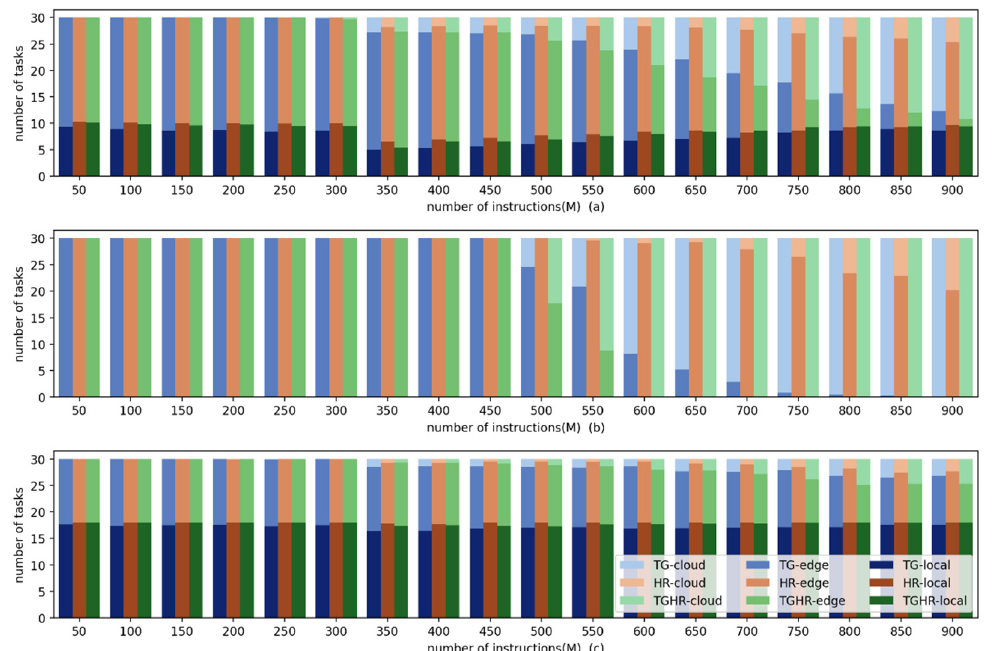
Figure 15. Allocation ratio of resource in different number of task instructions. ( a ) Allocation ratio of resource in all Pareto fronts; ( b ) Ratio of resource in near low-time 100 solutions; ( c ) Allocation ratio of resource in near low-cost 100 solutions.